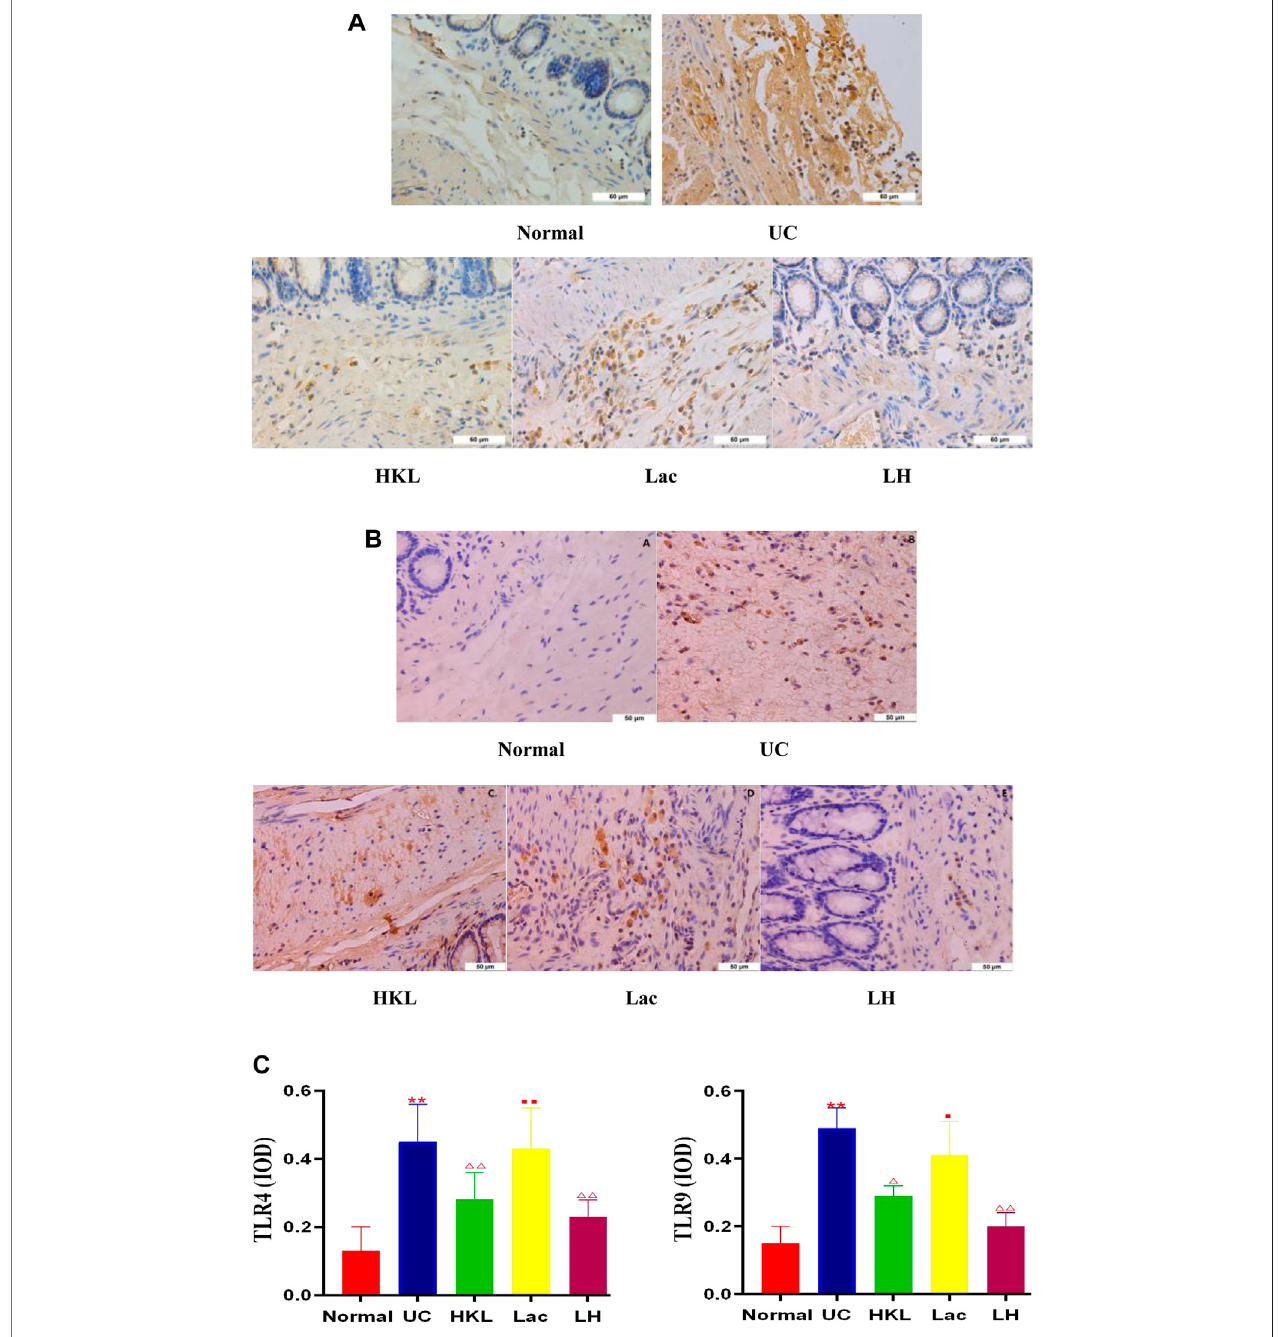
FIGURE 2 | LH treatment reduced TLR4 and TLR9 expression in vivo . (A) TLR4 immunohistochemical staining in colon tissue. (B) TLR9 immunohistochemical staining in colon tissue. (C) Quantitative determination of immunochemical (IHC) index of TLR4 and TLR9 positive signals. Data are shown as mean + SD ( n = 8). ** p < 0.01 vs. normal group; Δ P < 0.05, ΔΔ P < 0.01 vs. UC group; ■ p < 0.05, ■■ p < 0.01 vs. LH